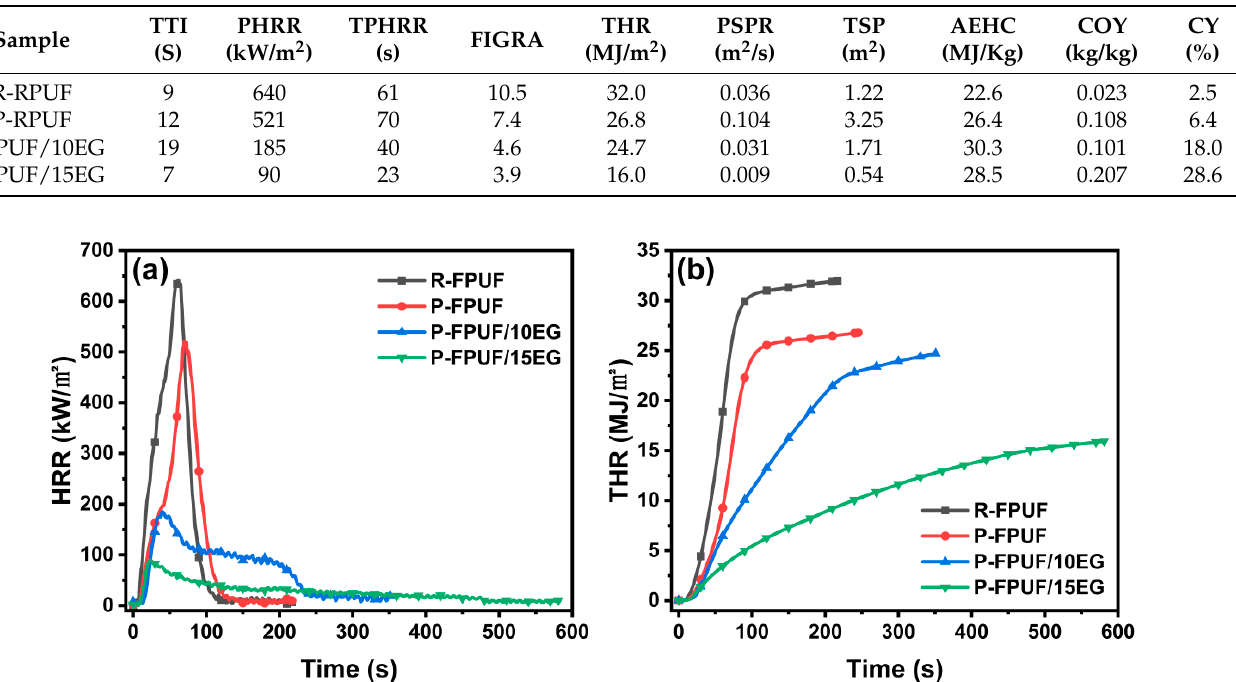
Figure 6. Smoke production rate ( a ) and total smoke production ( b ) for FPUFs.